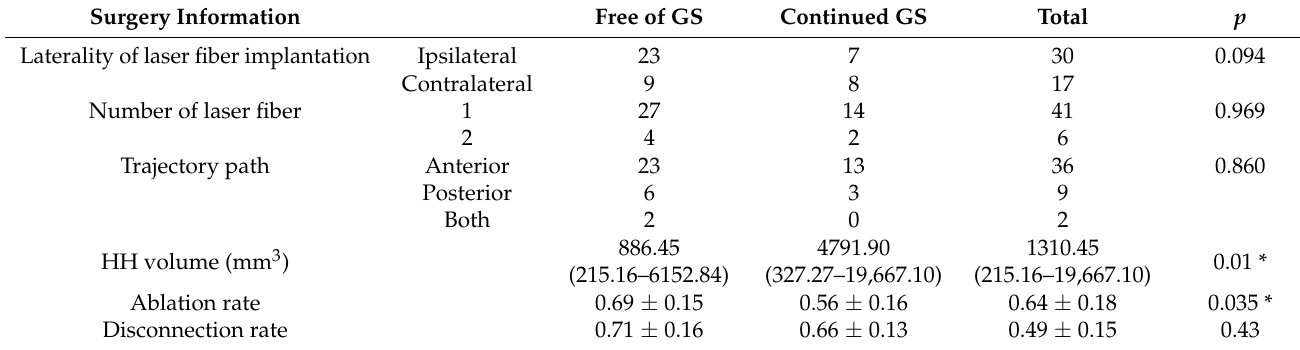
Table 3. Surgery